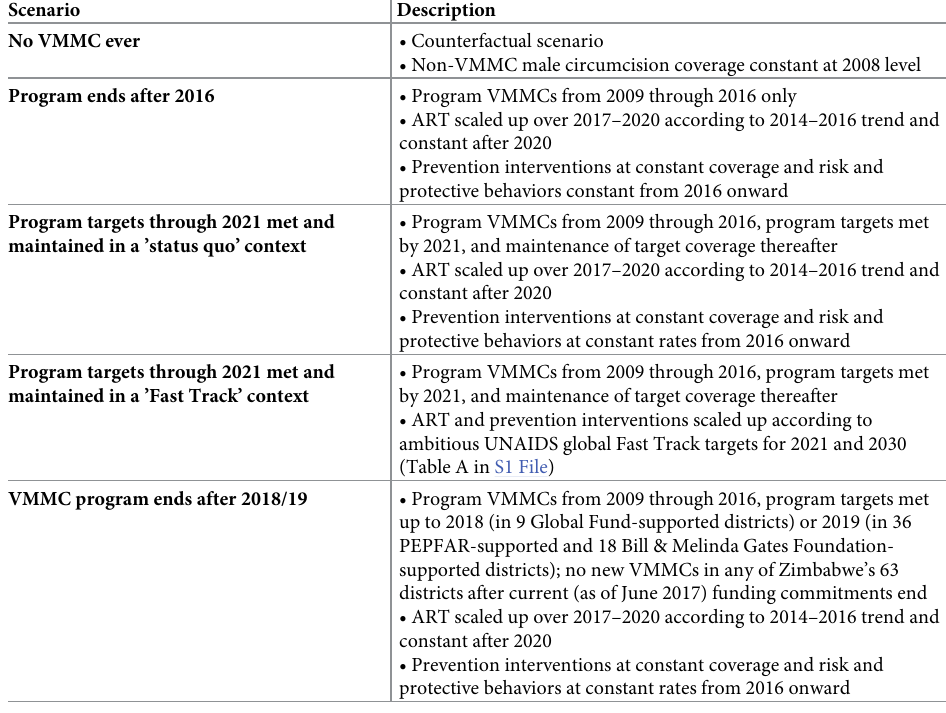
Table 1. VMMC scale-up scenarios